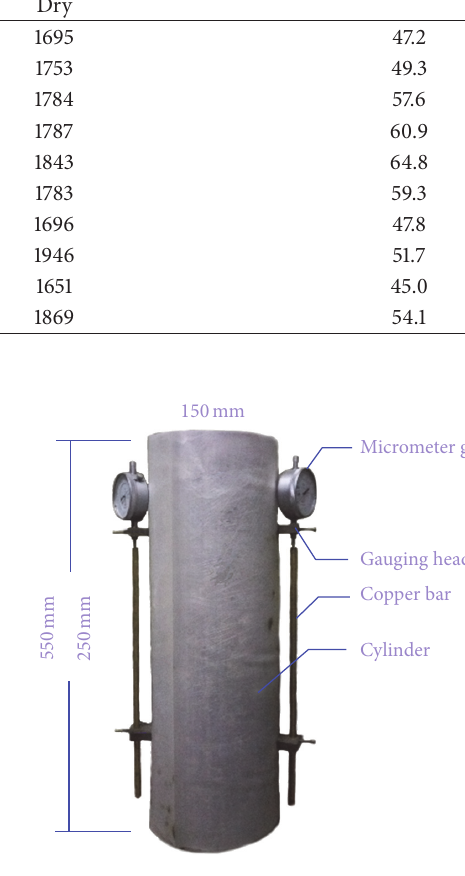
Figure 2: Measuring device for autogenous